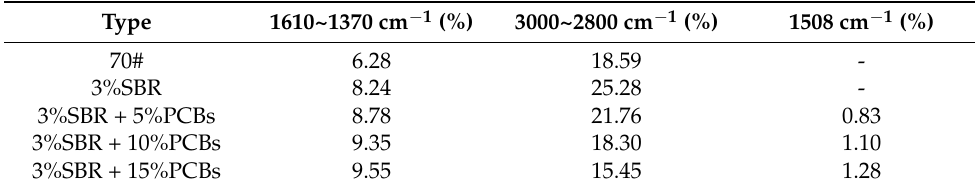
Table 9. The results of area proportion of functional